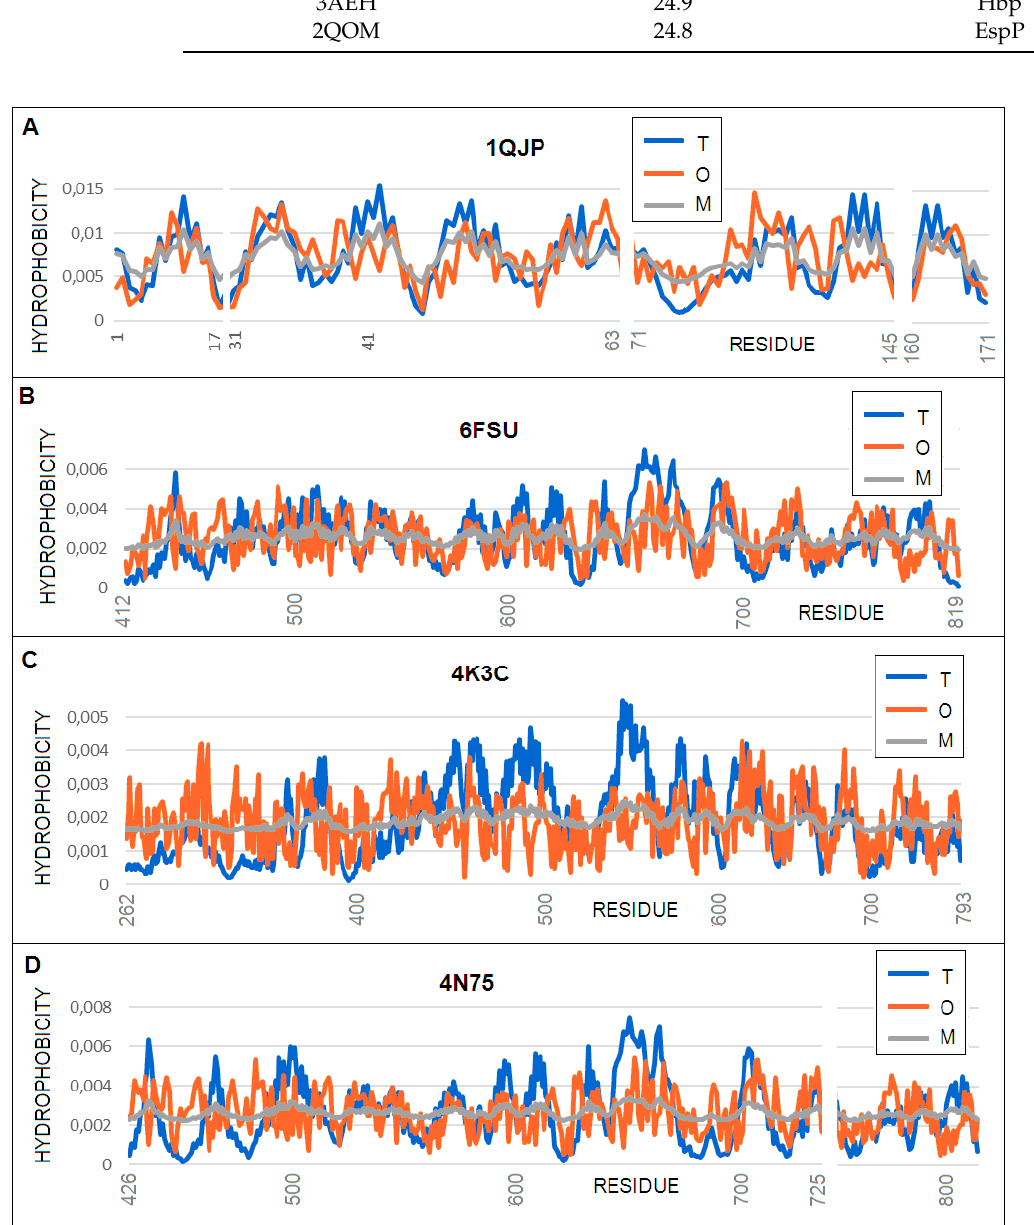
Figure 6. Profiles: T (blue), O (red), and M (gray) for the membrane proteins with a larger tunnel diameter. ( A ) 1QJP, profile M for K = 0.4; ( B ) 6FSU, profile M for K = 0.9; ( C ) 4K3C, profile M for K = 1.2; and ( D ) 4N75, profile M for K = 1.2.